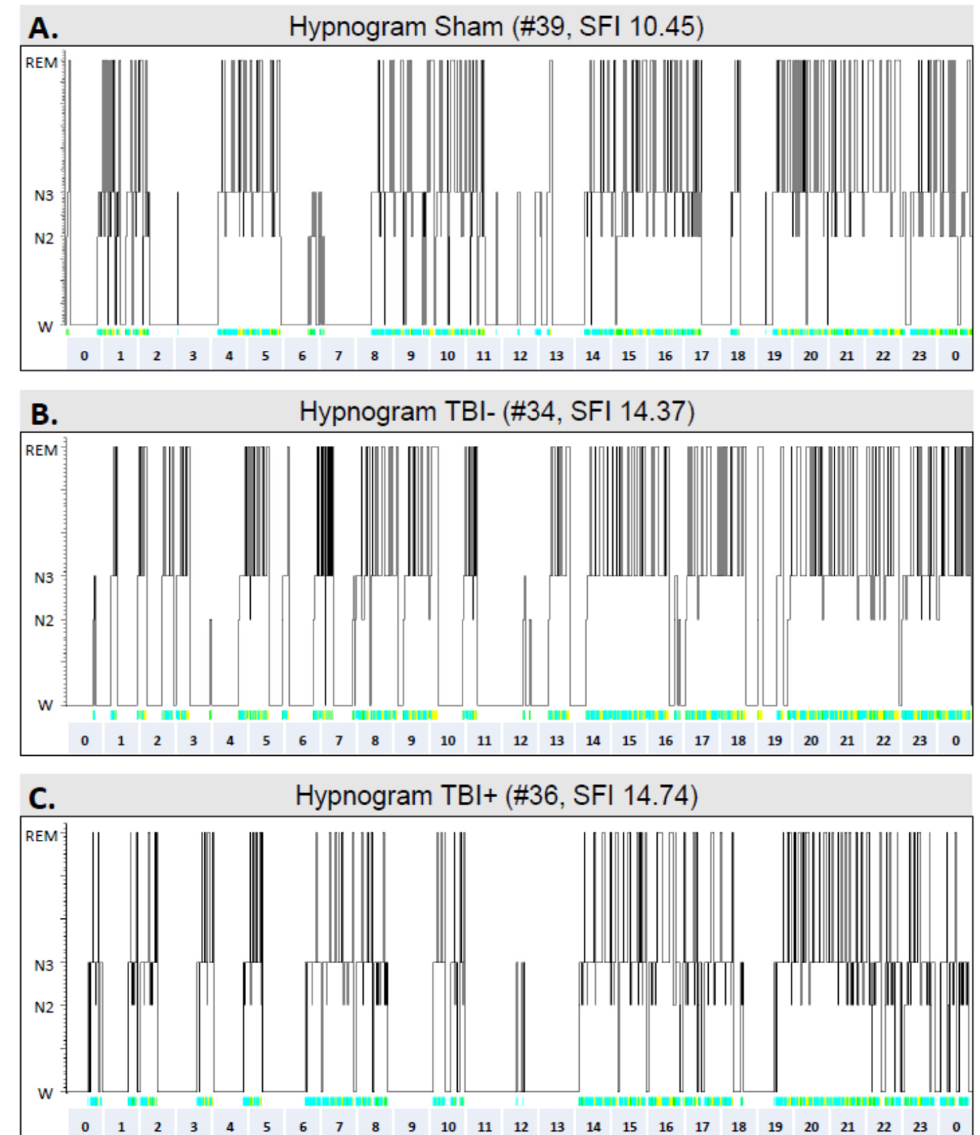
Figure 8. Hypnograms showing the sleep architecture in different groups over a 24-hour period in the 7th follow-up month: ( A ) A sham-operated control (#39). ( B ) A rat (#34) with TBI but no epilepsy (TBI − ). ( C ) A rat (#36) with TBI and epilepsy (TBI+). Note the fragmented sleep–awake cycle in TBI animals. Abbreviations: N2, N2 sleep stage; N3, N3 sleep stage; REM, rapid eye movement sleep;